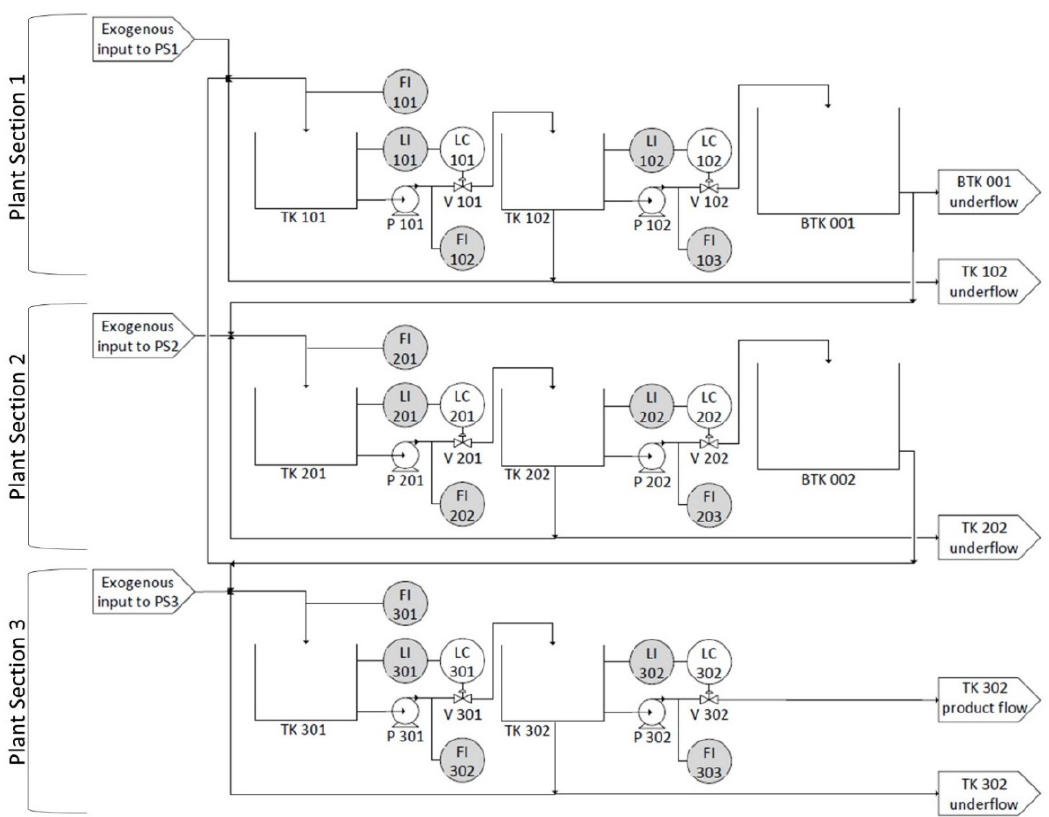
Figure 2. Diagram of tank network consisting of three PSs. PSs are indicated by open brackets on the left-hand side and the first number in each tag name indicates its PS. Shaded sensors indicate measured variables. LI, level indicator; FI, flow indicator; LC, level controller; V, valve; P, pump; TK, tank; BTK, buffer tank.